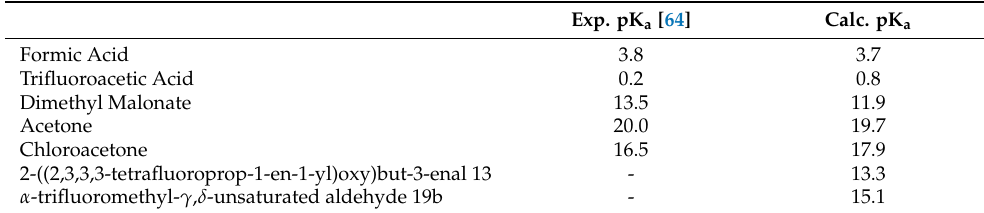
Table 1. Values of known experimental pK a , calculated pK a and calculated pK a with included obtained for Equation (1) parameters A and